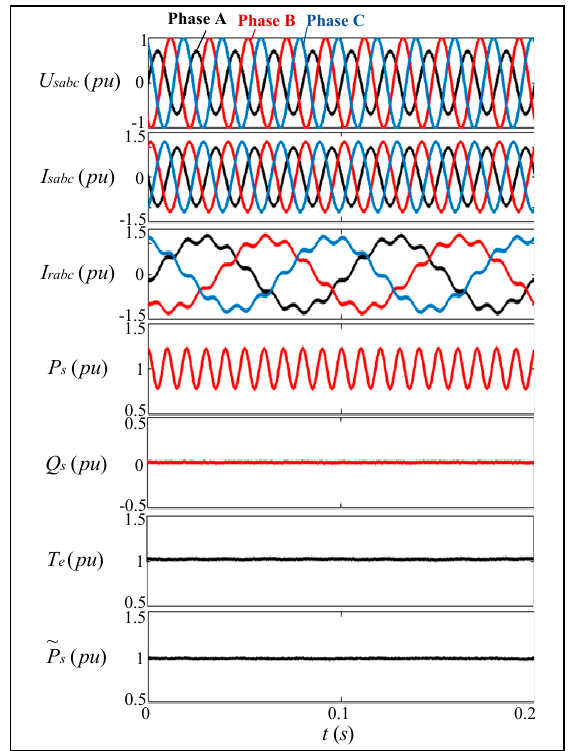
Figure 7. Proposed VSG control under a single-phase grid voltage drop of 30% (Target 1).